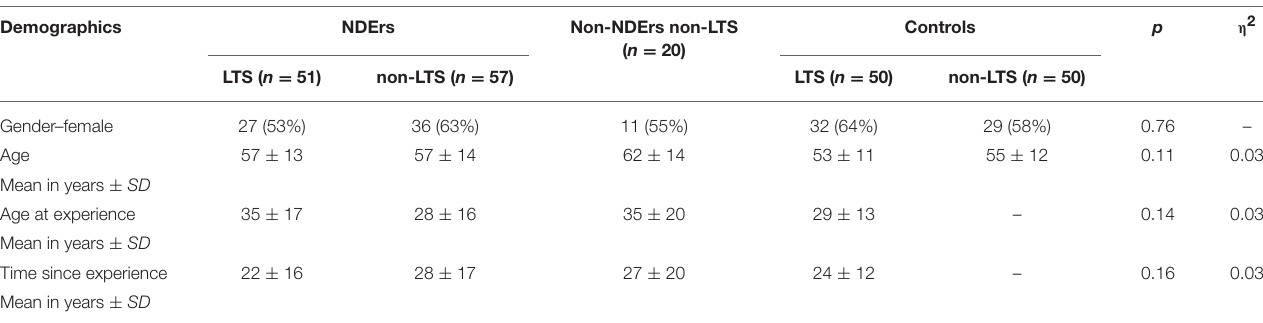
TABLE 1 | Demographic data of